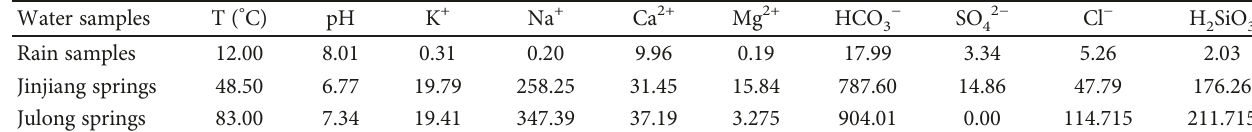
Table 1: Concentration of chemistry compositions on hydrogeochemistry simulation (mg/L).